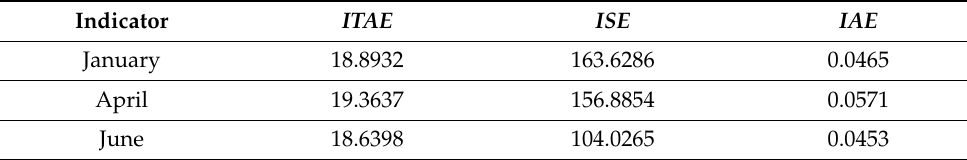
Table 3. Performance indicators in the center of Valle de Aburr á